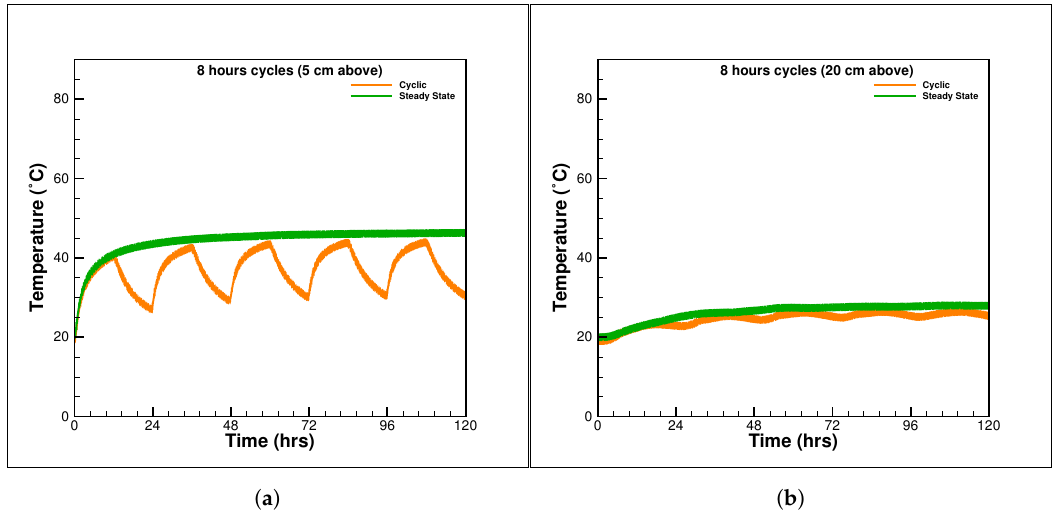
Figure 10. Comparison between cyclic and steady state heating condition at 70 °C ( a ) 5 cm; ( b ) 20 cm from the heater